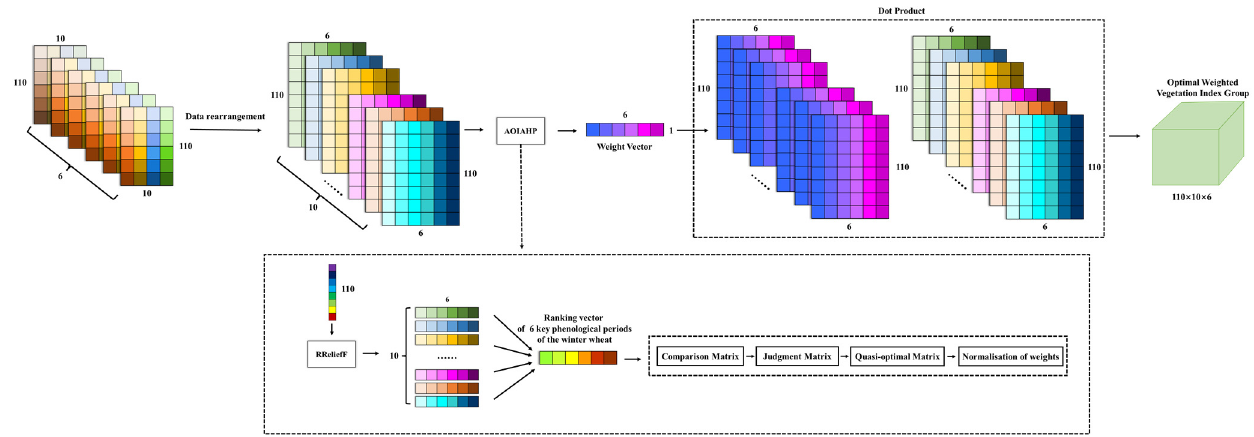
Figure 3. Method of obtaining the optimal weighted vegetation index group using AOIAHP of the study.